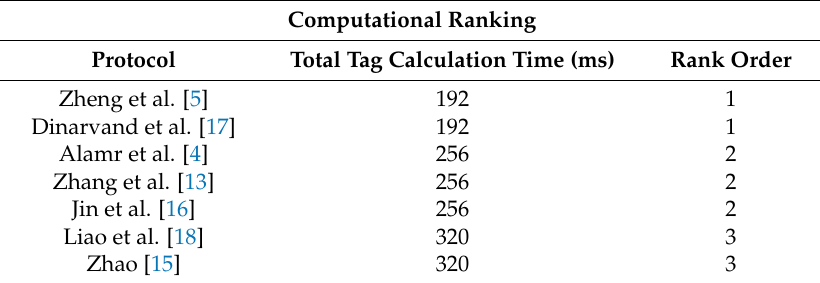
Table 6. Ranking based on tag computational cost.